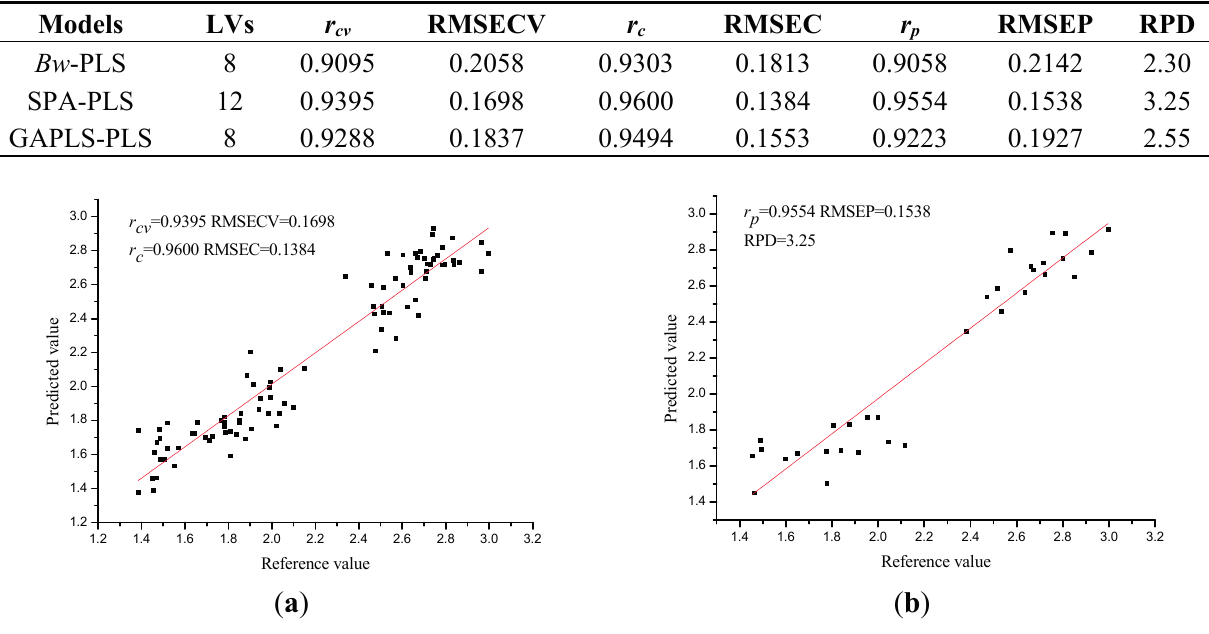
Figure 5. Prediction results of the calibration set ( a ) and the prediction set ( b ) of PLS model using sensitive wavelengths selected by